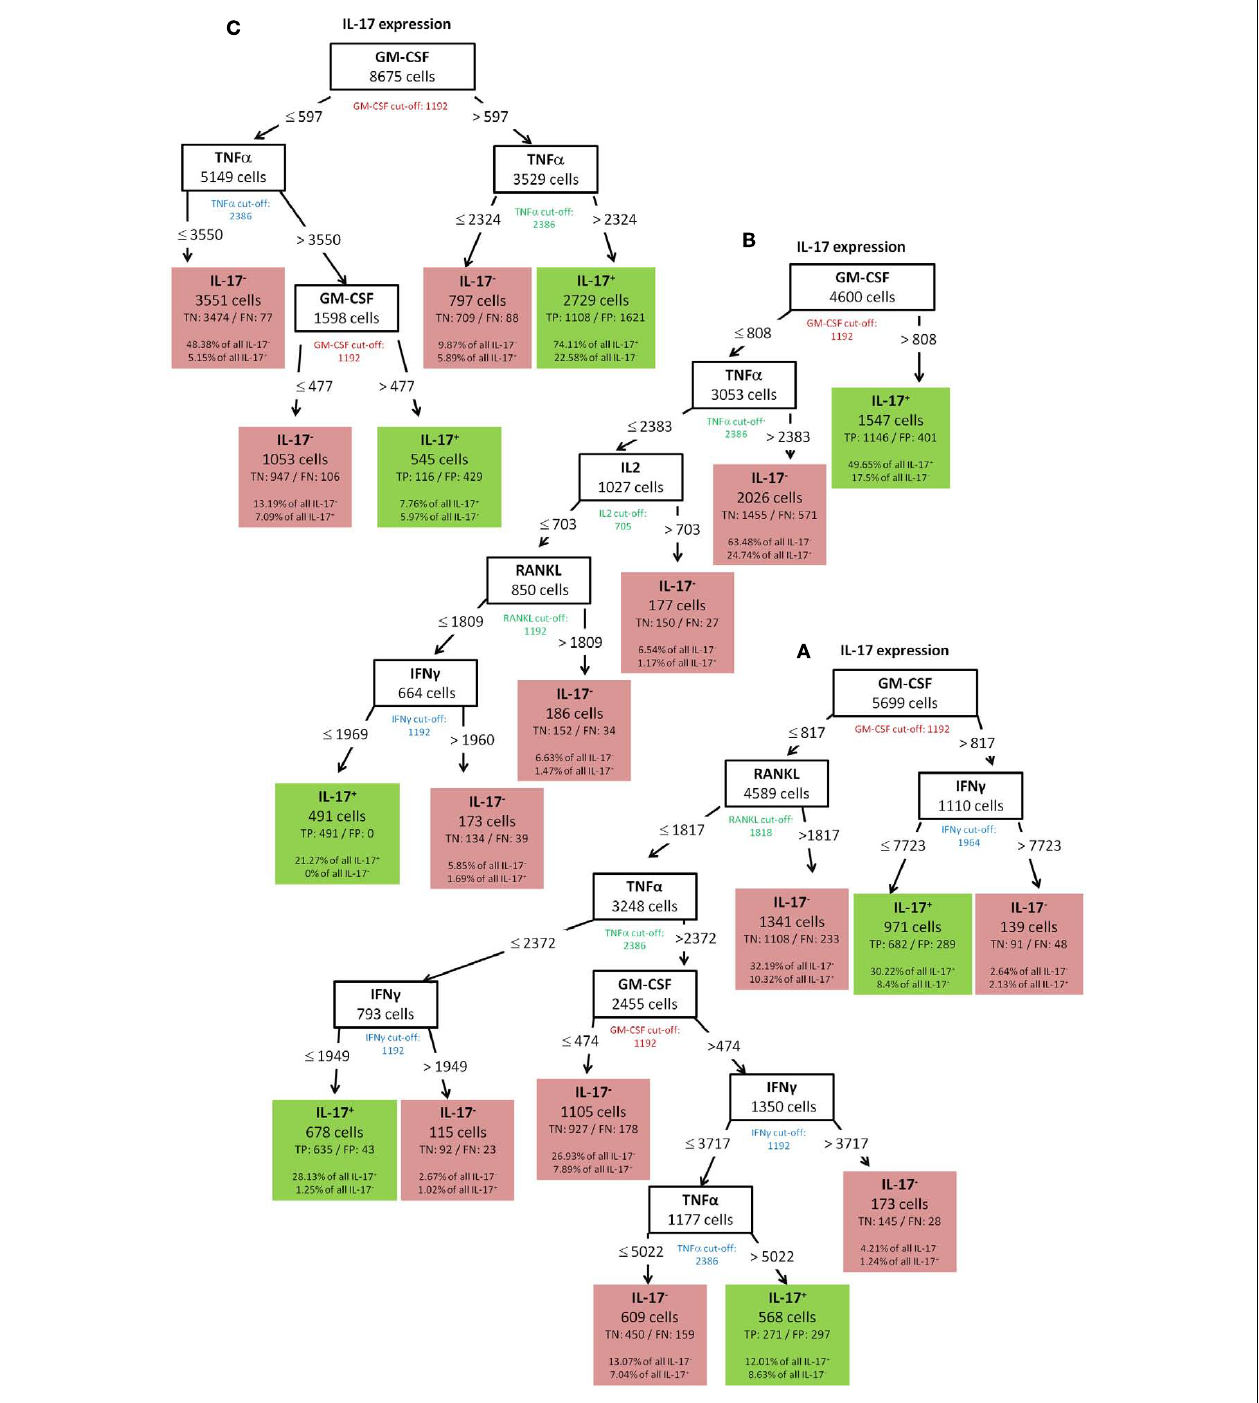
FIGURE 11 | IL-17 (A)WT-day 9, (B) KO-day 9, (C) KO-day